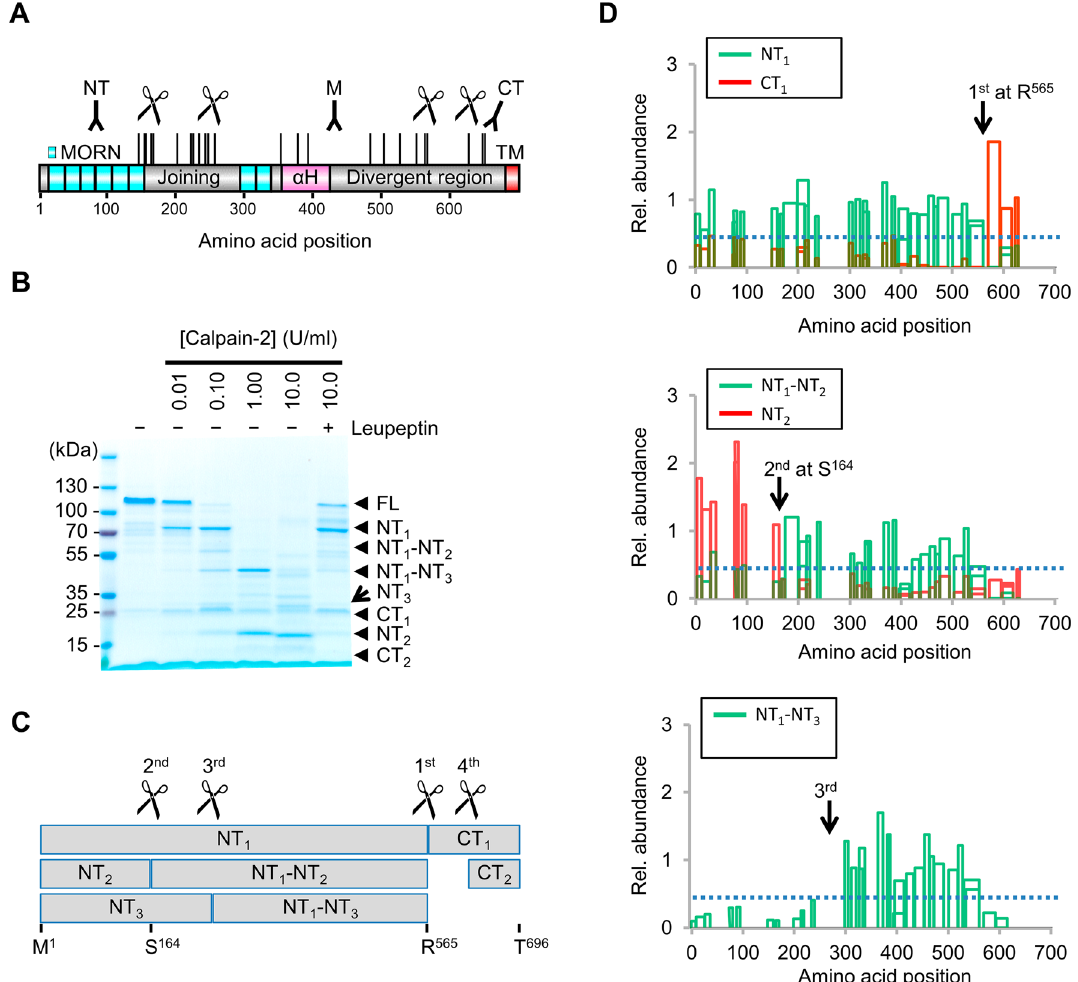
Figure 1. Identification of Calpain-specific cleavage fragments of JP2. ( A ) Mouse FL JP2 domain representation (Uniprot: Q9ET78) summarizing the in silico prediction of Calpain cleavage sites by the DeepCalpain tool. Predicted cleavage sites are indicated by vertical black lines above the JP2 topology domain model. Experimentally confirmed cleavage events observed at 0.1 U/ml Calpain-2 are indicated by scissors. The approximate epitope binding positions of three different JP2 antibodies are indicated by Y-shaped symbols: NT, N-terminal region; M, middle region; CT, C-terminal region. ( B ) The Calpain-2 activity specific cleavage patterns of the mouse FL JP2 substrate. Purified recombinant JP2 was incubated at increasing Calpain-2 concentrations for 30 min at 30 °C, followed by SDS-PAGE and Coomassie staining. ( C ) Box plot summarizing the JP2 cleavage events (scissors), fragments, and cleavage sites experimentally observed for the 0.1 U/ml Calpain-2 concentration. ( D ) LC-MS/MS analysis of the spectrum of mouse JP2 fragments generated by Calpain-2 digestion. Tryptic peptide counts are represented as relative abundance versus the JP2 amino acid position. Arrows indicate the positions of the first, second, and third cleavage